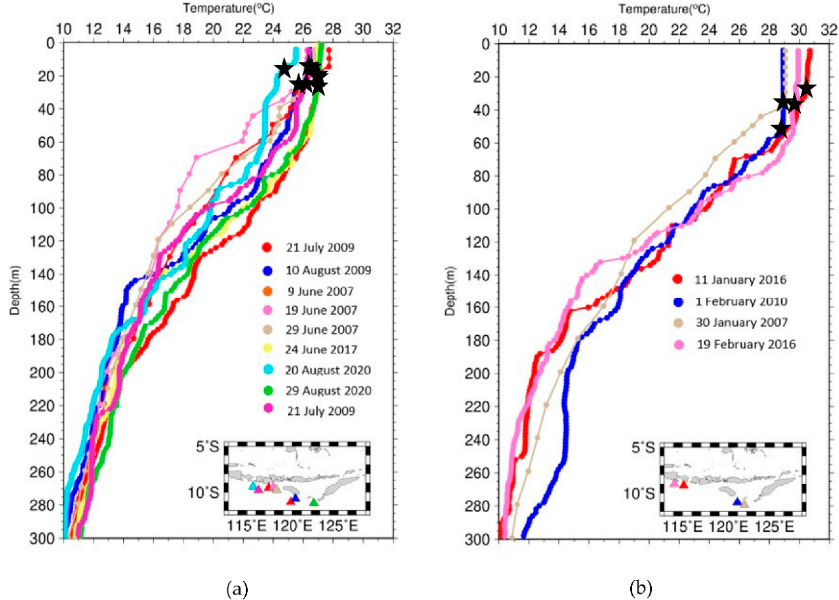
Figure 12. Argo float data during ( a ) the southeast monsoon season and ( b ) the northwest monsoon season. The black star symbols indicate the calculated values of mixed layer depth. Table 2. Correlation between monthly averages of sea surface temperature (SST), Ekman Mass Transport (EMT), and Ekman Pumping Velocity (EPV) in all boxes from 2007 to 2020.